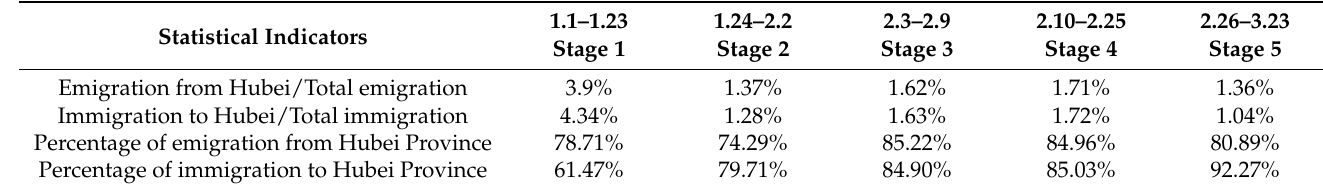
Table 2. Statistical table of PFN in Hubei Province.